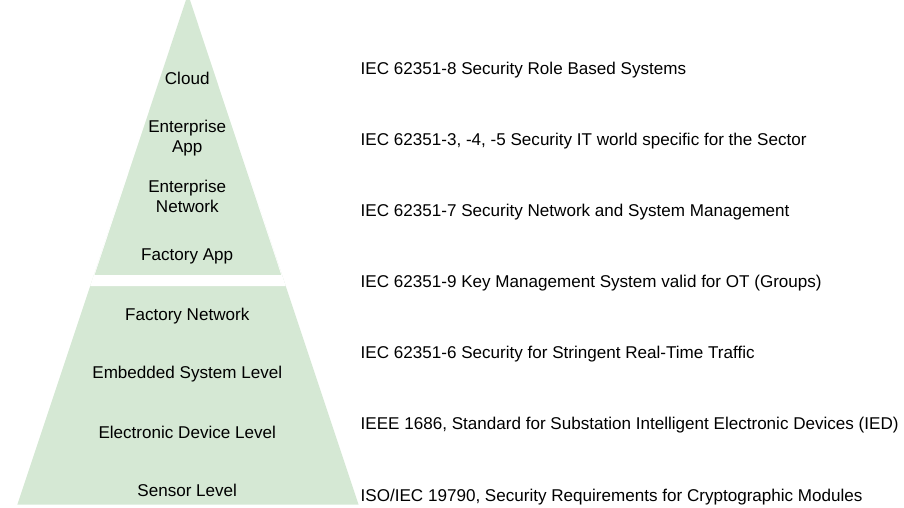
Figure 6. Security standards for the power system information